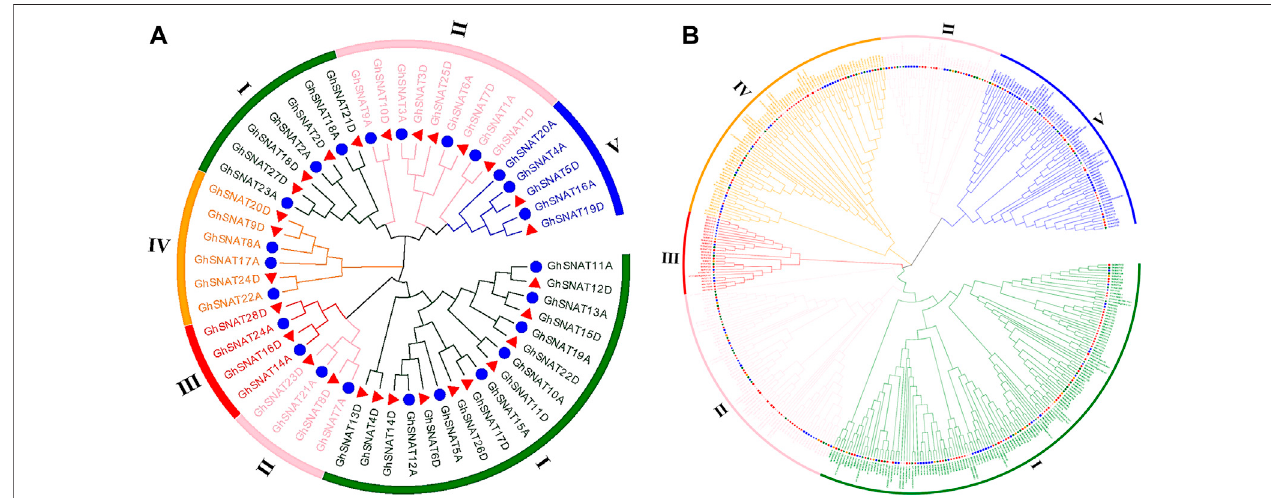
FIGURE1| TwounrootedphylogenetictreeswereconstructedbytheMEGA7,NeighborhoodmethodwasusedtodrawtheevolutionarytreeofGhSNATsfamily, and Maximum Likelihood method was used to draw the interspeci fi c evolutionary tree of SNATs. (A) : Evolutionary analysis of members of the SNAT family Gossypium hirsutum ; (B) : Phylogenetic relationships of 468 SNAT proteins from cotton, Theobroma cacao , Arabidopsis thaliana , Oryza sativa , Populus trichocarpa , Vitis vinifera , Glycine max , Zea mays